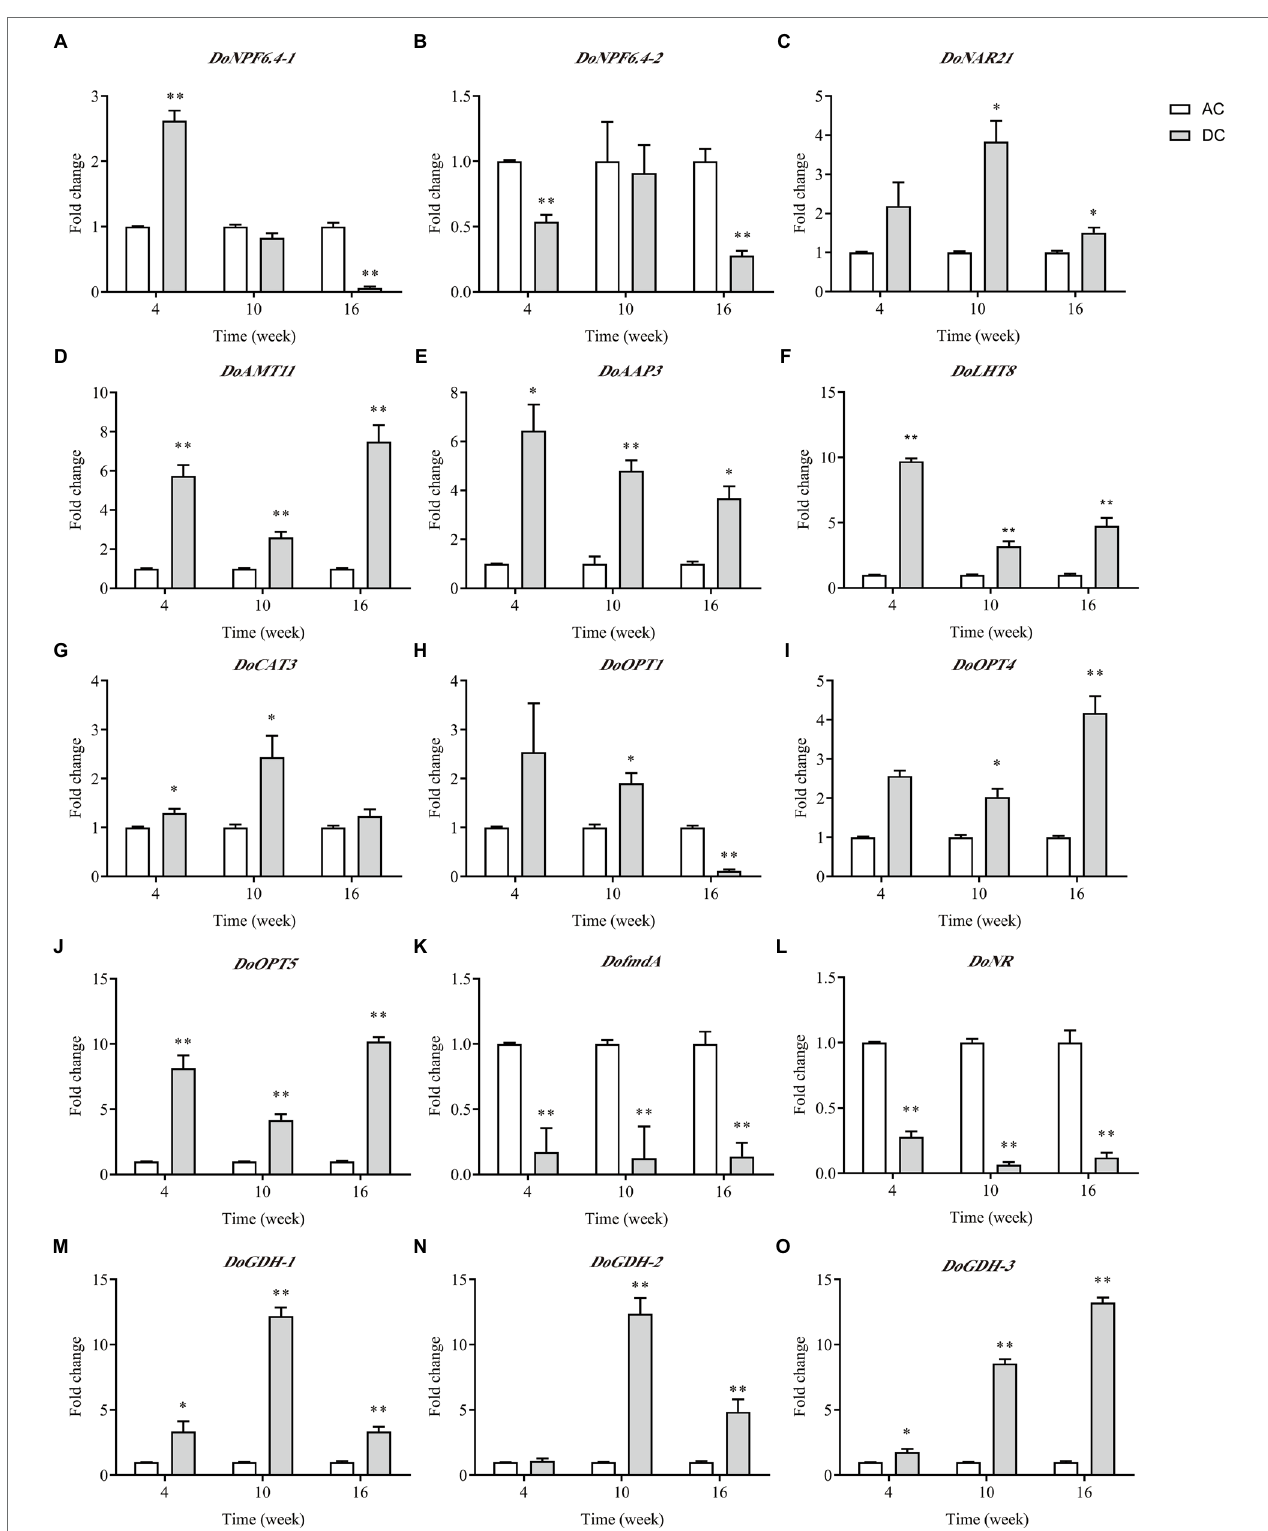
FIGURE 5 | qRT-PCR analysis of DEGs related to N metabolism in D. officinale ( n = 3). (A–J) : DEGs of N transporters. (J–O) : DEGs involved in N metabolism. The Y-axis represents the mean fold changes in expression values. AC, axenic culture and DC, dual culture. * p < 0.05; ** p <